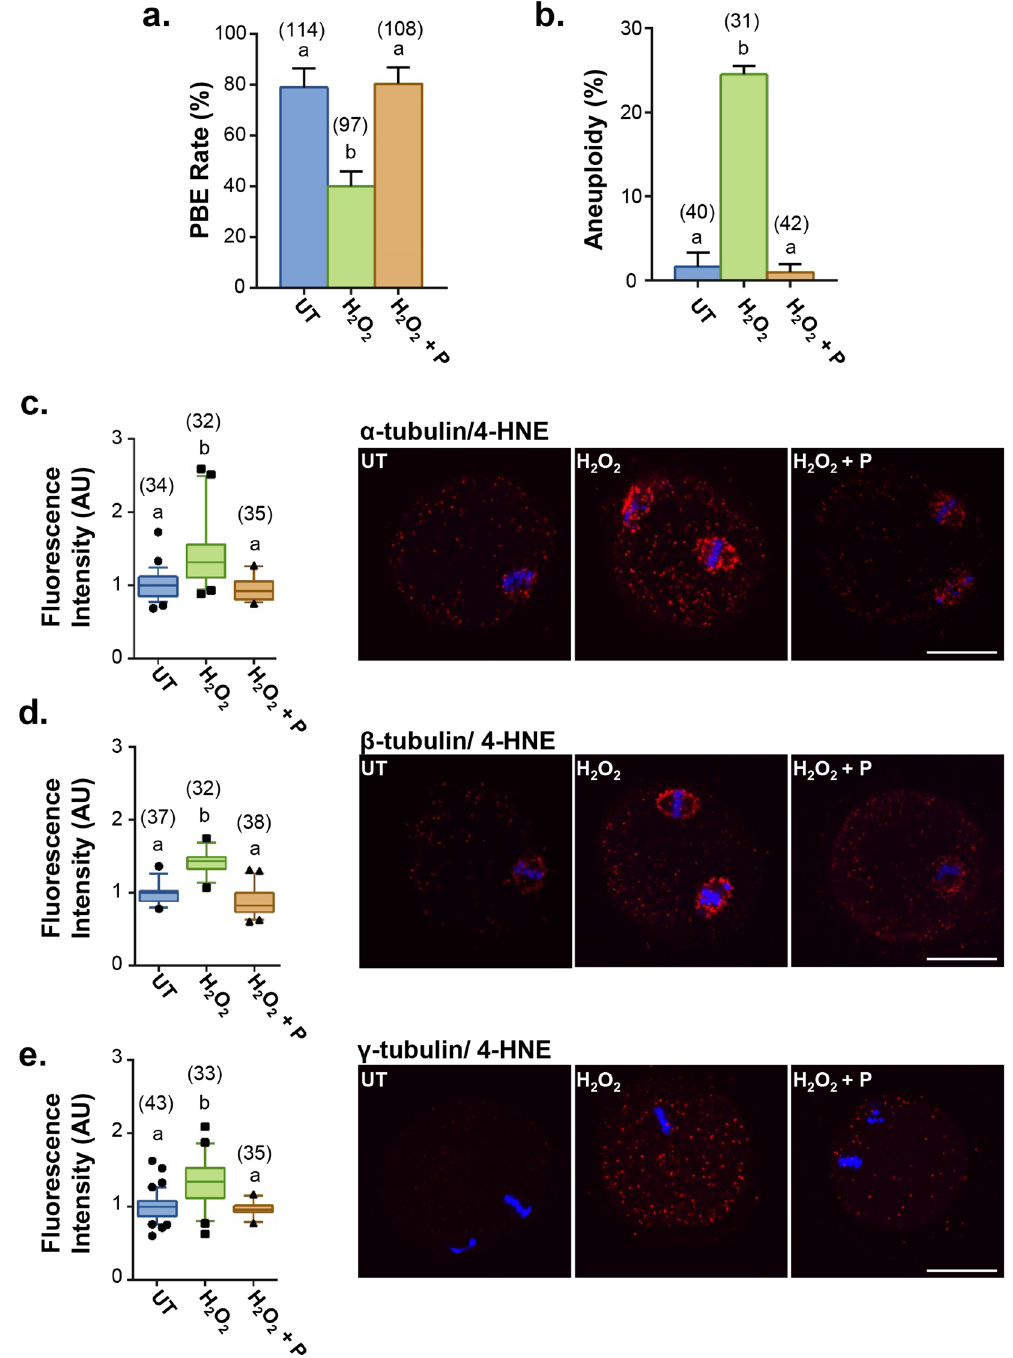
Figure 8. 4-HNE adduction can be ameliorated by treatment with penicillamine. GV oocytes were either untreated (UT) or treated for 1 h with either 35 μ M H 2 O 2 (H 2 O 2 ) or 35 μ M H 2 O 2 and 1 mM penicillamine (H 2 O 2 + P) followed by IVM. Treatment with penicillamine during H 2 O 2 was able to negate the effect of H 2 O 2 on ( a ) meiotic completion ( p ≤ 0.0002) and ( b ) aneuploidy rates ( p ≤ 0.0001). Error bars represent SEM. ( c ) Upon treatment with H 2 O 2 , fluorescence intensity of PLA (red) showed an increase in 4-HNE adduction to ( c ) α - ( p ≤ 0.0309) ( d ), β - ( p ≤ 0.0037) ( e ) and γ -tubulin ( p ≤ 0.0001) which was ameliorated by treatment with penicillamine during oxidative insult. Scale bar = 20 μ m. Nuclei were counterstained with Hoechst (blue). Box and whisker plots shows mean as the centreline, box as the 25–75th percentiles and whiskers as the 10–90th percentiles. PLA was performed with three biological replicates with each replicate comprising between 10–30 oocytes pooled from a minimum of three